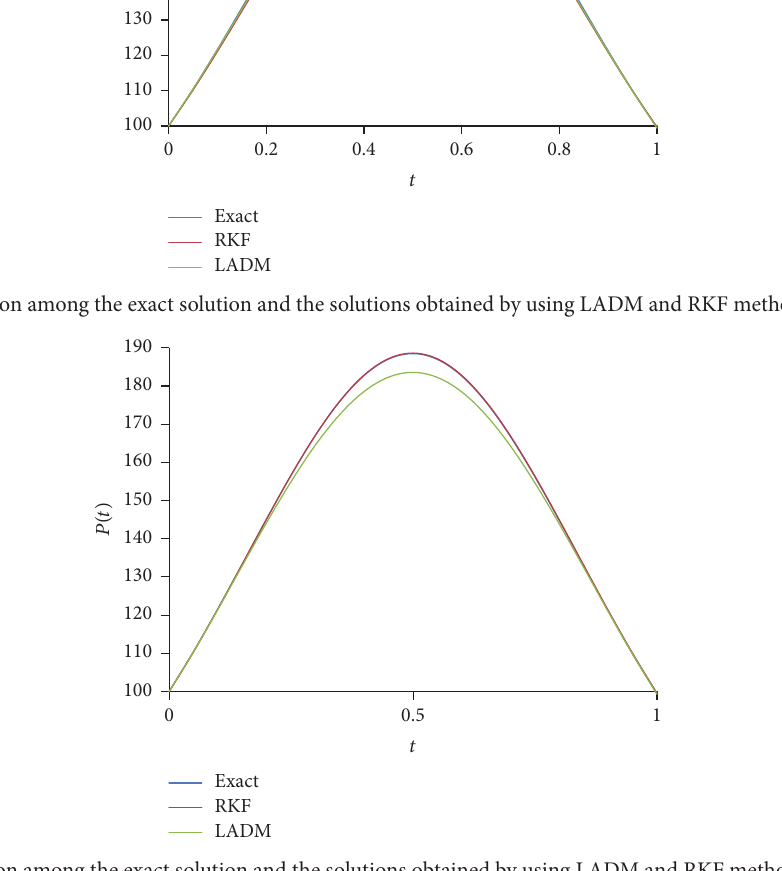
Figure 3: Evaluation among the exact solution and the solutions obtained by using LADM and RKF method for model